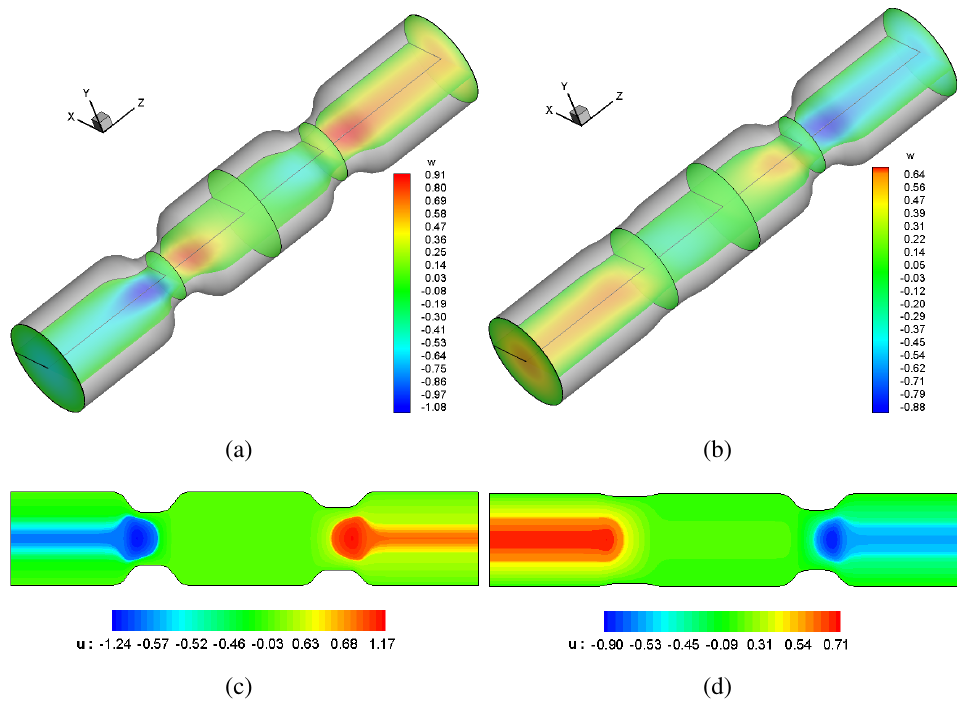
= 30 ◦ ; ( b ) 3D 12 = 30 ◦ ; ( d ) 2D theory at 12